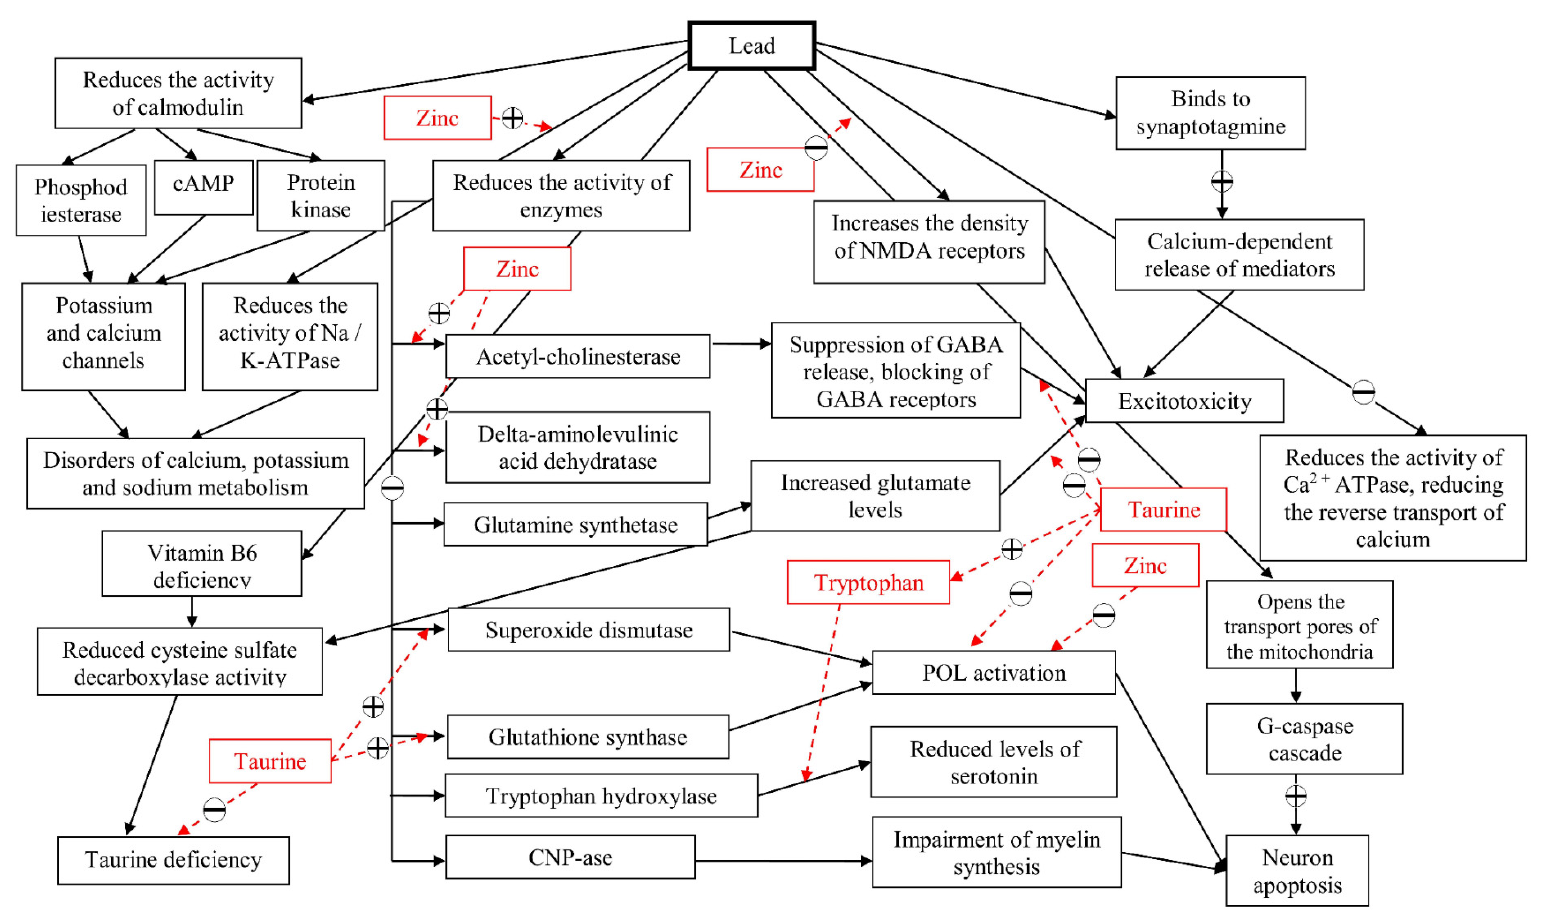
Figure 5. The main molecular mechanisms of the deteriorating effect of lead on nervous tissue and the ways in which the components of the mixture influence these mechanisms. Note: “+”—parameter gain; “ − ”—parameter reduction.